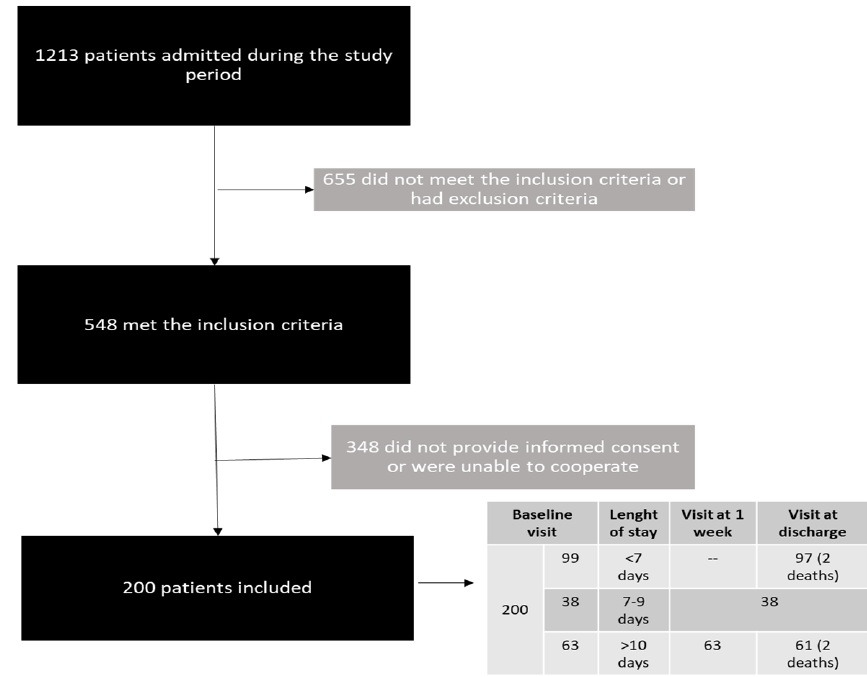
Figure 1. Selection of patients included in the study.